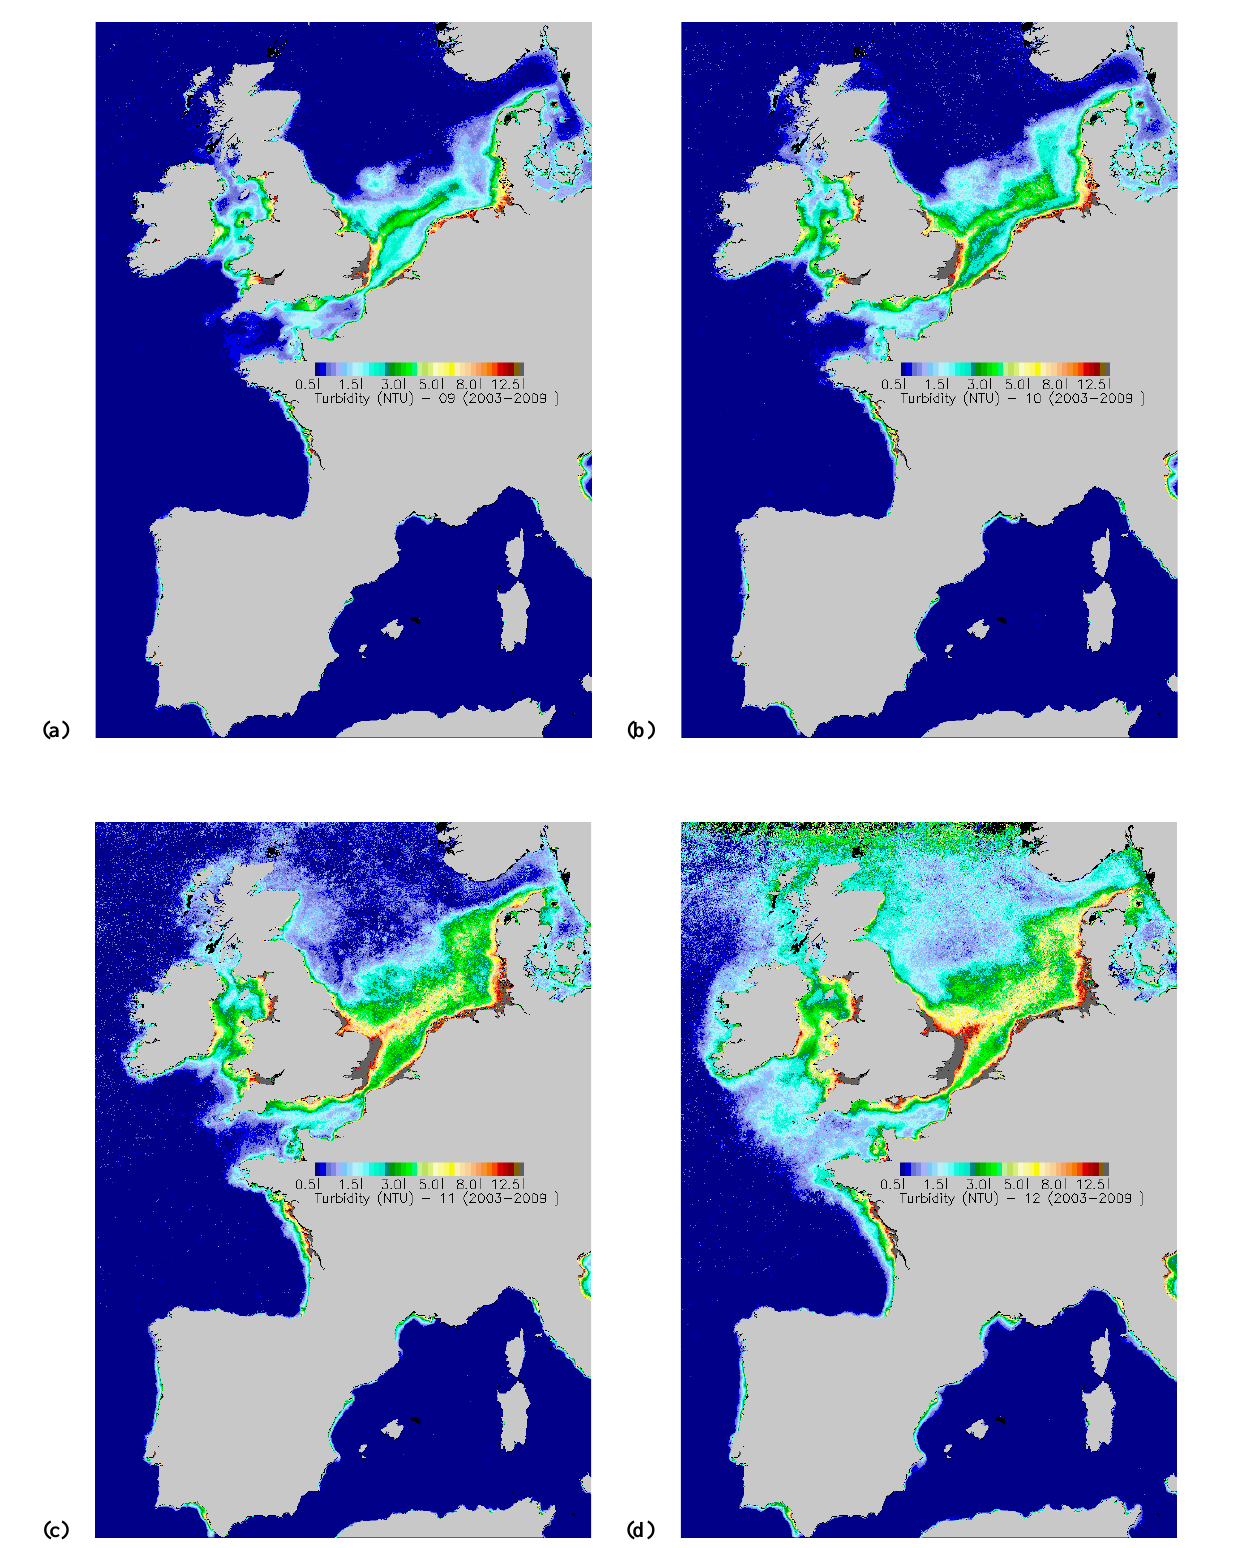
Fig. C3. Monthly turbidity in September (a) , October (b) , November (c) and December (d)